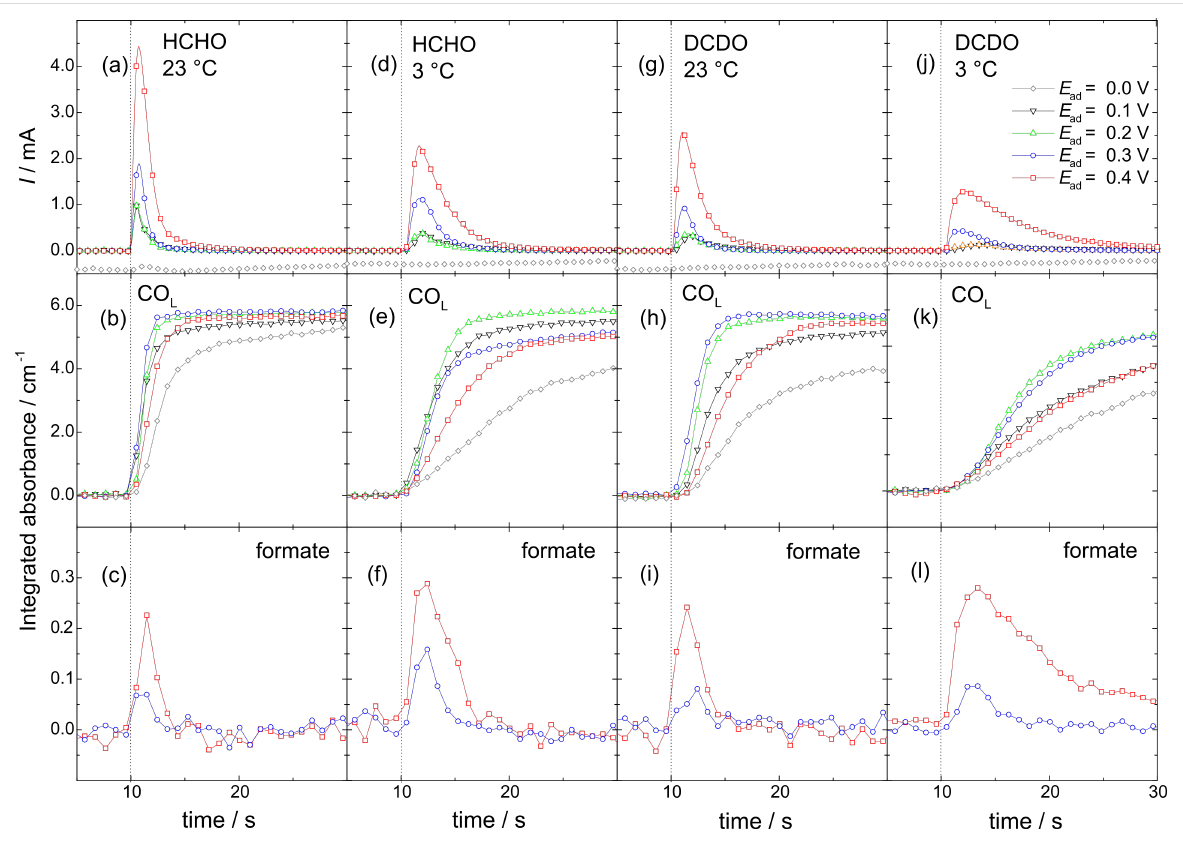
Figure 3: Transients of Faradaic current (upper panel) and integrated intensities of linearly bonded CO ad (middle panel) and adsorbed bridge-bonded formate (for 0.3 and 0.4 V only) bands upon admission of 0.1 M H2- or D2-formaldehyde solution in 0.5 M HClO 4 to a Pt film electrode biased at 0.0, 0.1, 0.2, 0.3 and 0.4 V at 23 or 3 °C temperature (see figure for